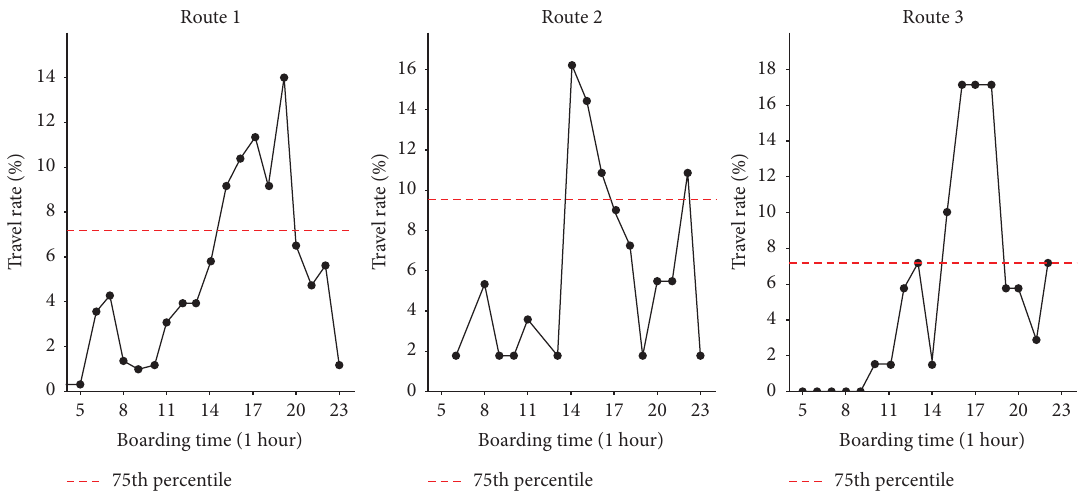
Figure 16: Travel rate by time for < residence-I > routes.